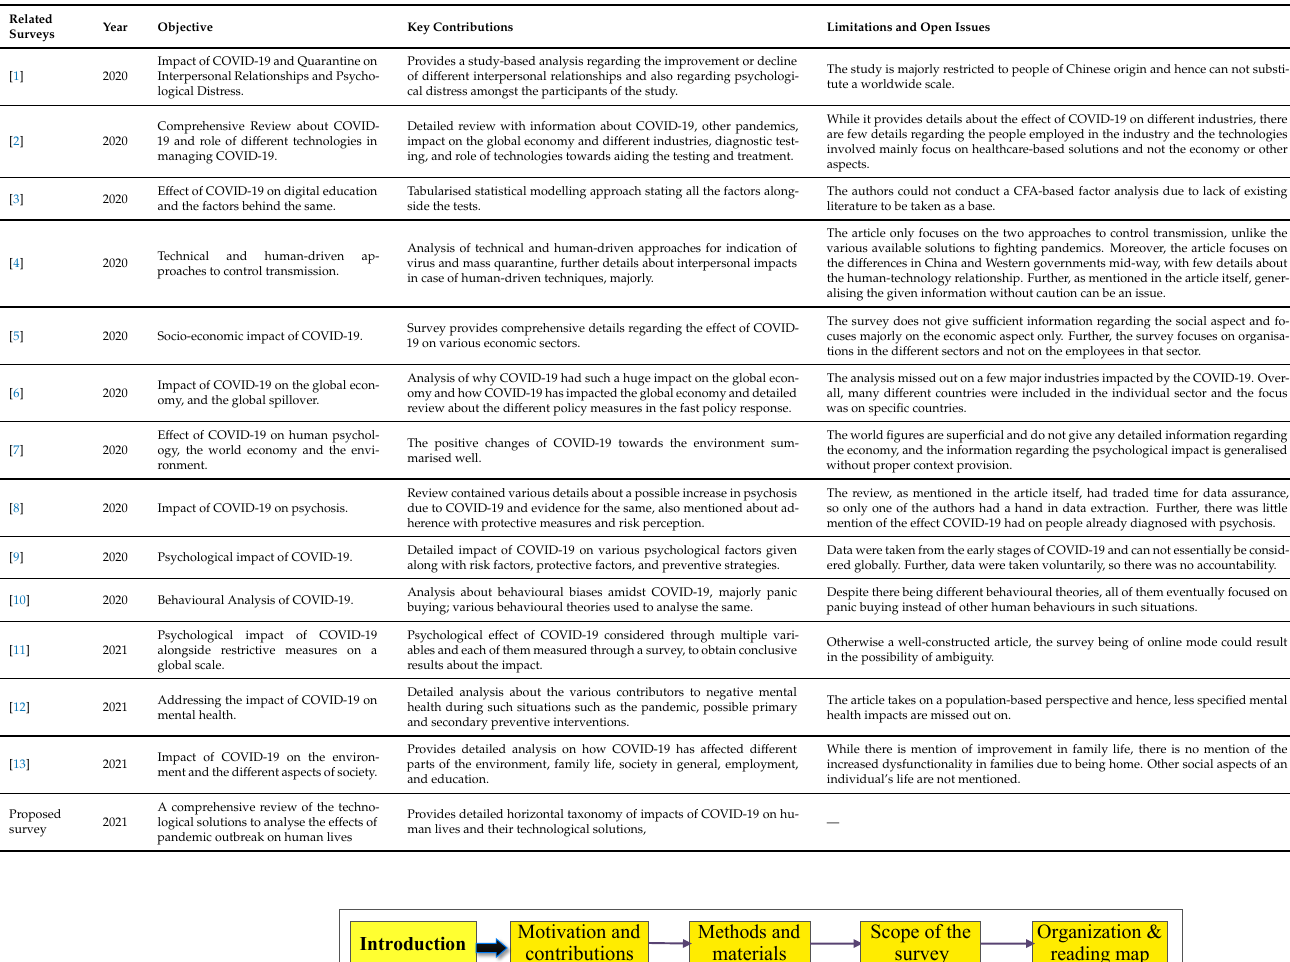
Table 3. Relative comparison of the existing surveys with the proposed survey.